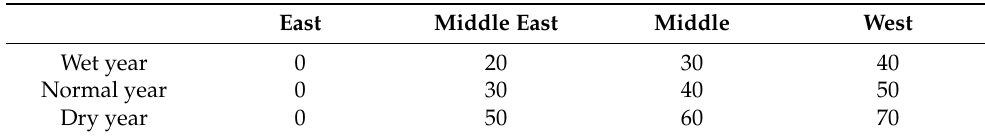
Table 2. Irrigation water used in different regions in Jilin Province under different rainfall years (m 3 /hm 2 ).